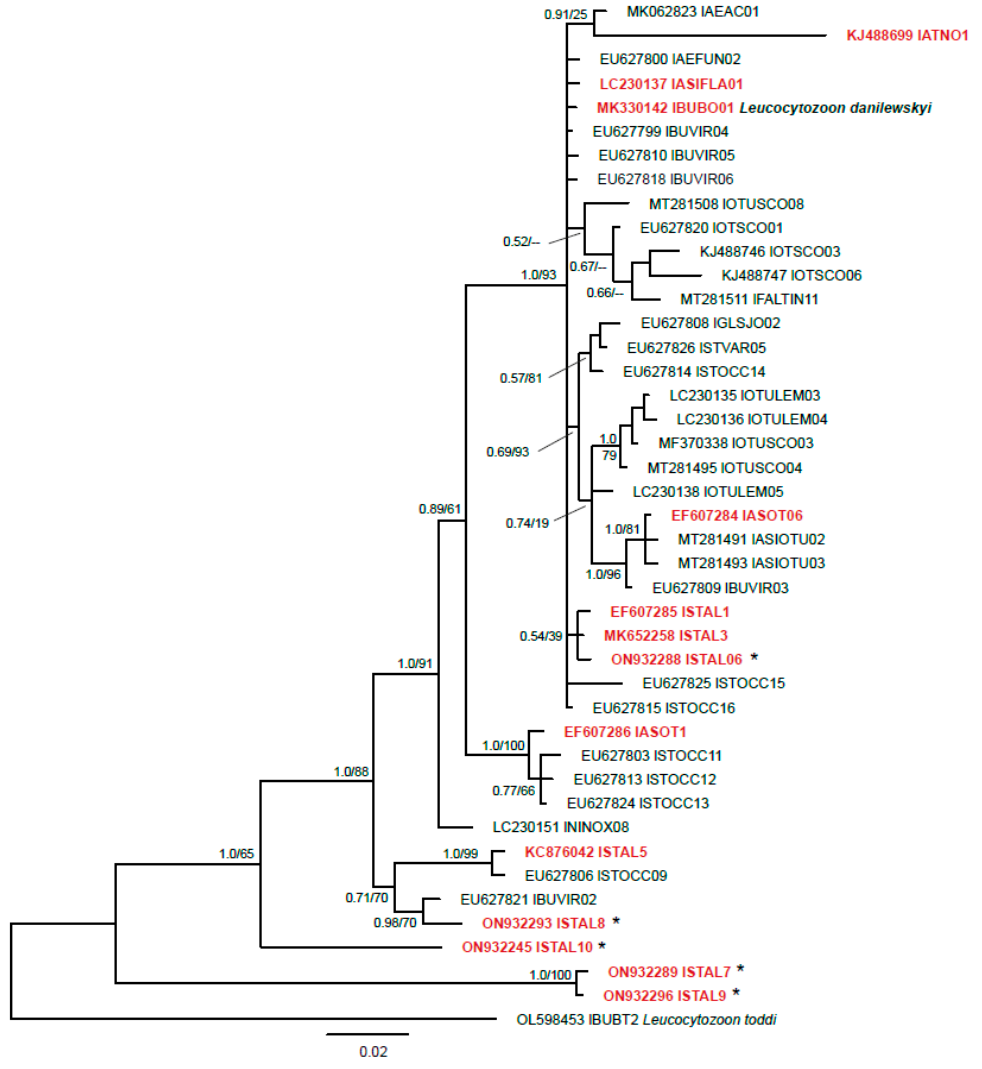
Figure 2. Bayesian Inference tree of 43 partial (474 bp) Leucocytozoon cytB lineages (474 bp). Lineages found in the present study are provided in red bold letters. Most lineages (excluding lSTAL7, lSTAL9, and lSTAL10) clustered in a clade featuring multiple lineages from owls and other birds. For comparison, all owl parasite lineages clustering in this clade were included but approximately 40 lineages from non-strigiform birds were excluded a priori. A sequence of Leucocytozoon toddi lBUBT2 was used as outgroup. Lineages found for the first time are marked with an asterisk. Bayesian inference posterior probabilities and Maximum-likelihood bootstrap values are indicated at each node. The scale bars indicate the expected number of substitutions per site according to the model of sequence evolution applied. GenBank accession numbers are provided, followed by lineage names according to MalAvi database (http://130.235.244.92/Malavi/, accessed on 6 July 2022). In case the lineages were linked to morphospecies, the taxon name is